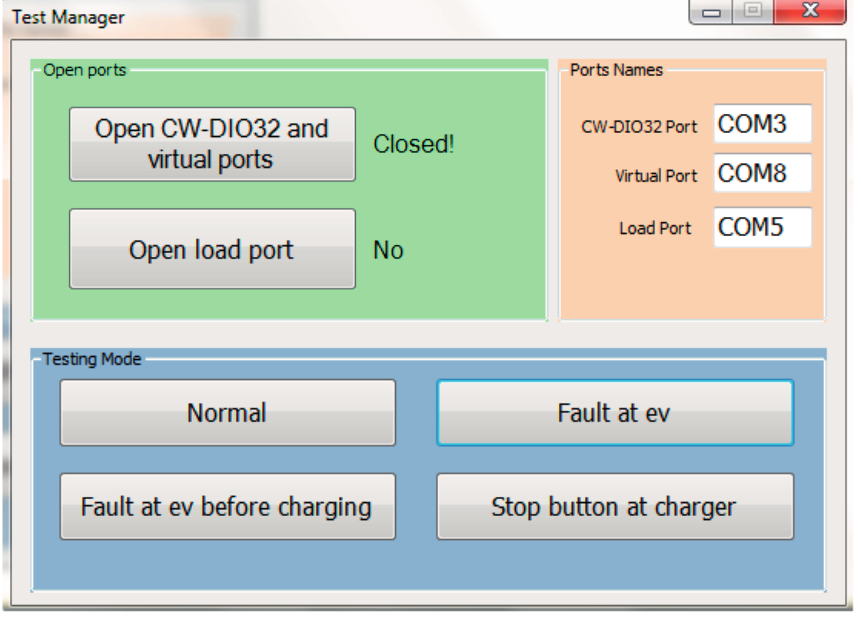
Figure 5. Main window of the test